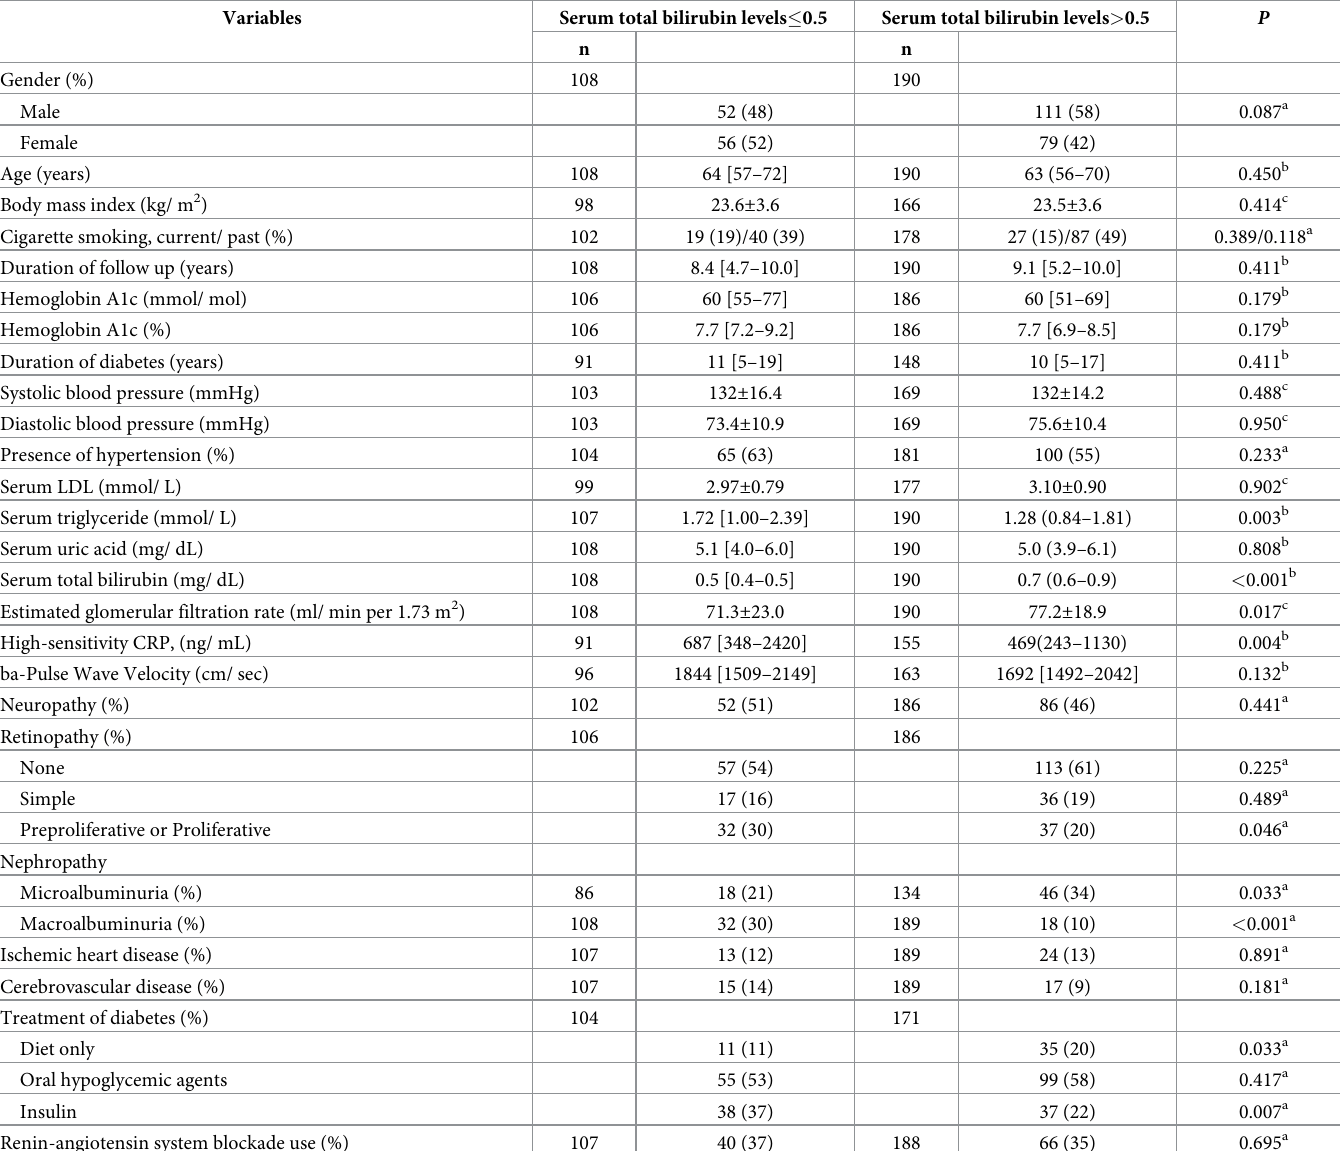
Table 3. Comparison in variables between two groups divided by the cut-off value of baseline serum total bilirubin levels. Variables Serum total bilirubin levels � 0.5 Serum total bilirubin levels >